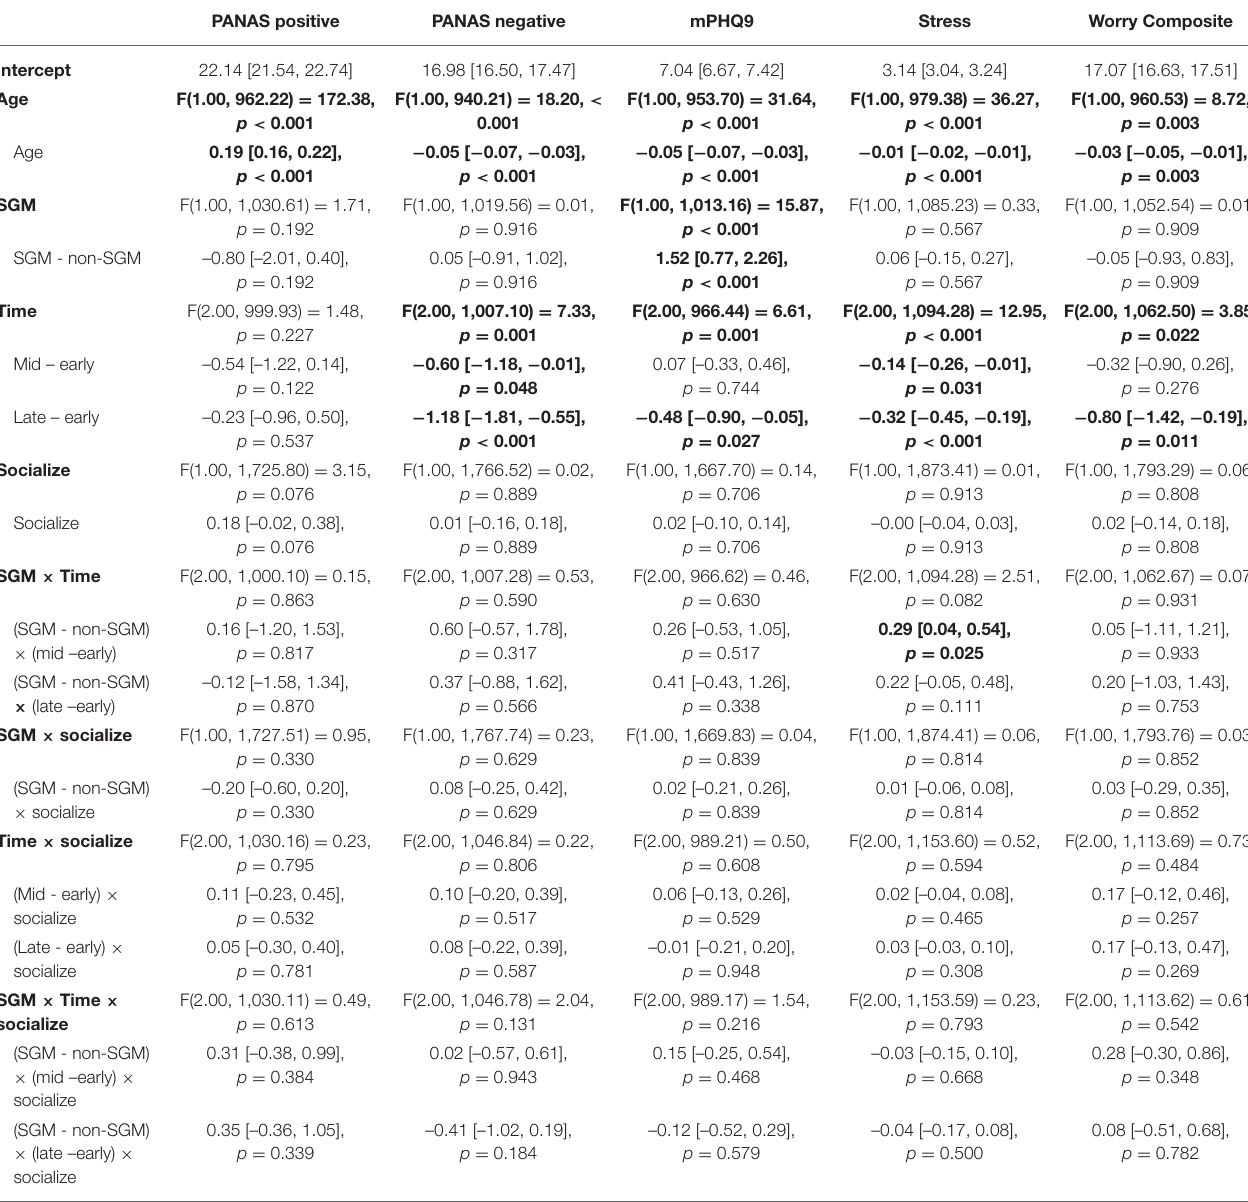
TABLE 4 | Model 3 regression